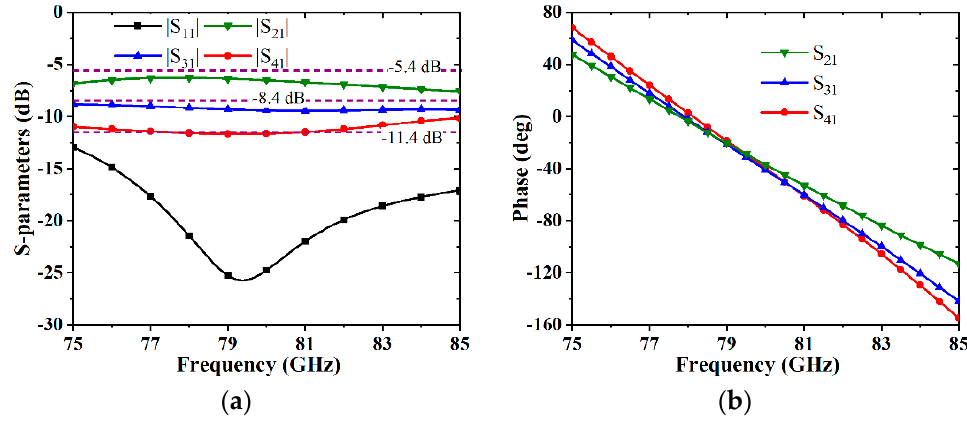
Figure 6. The simulated results of the feeding network. ( a ) S − parameters. ( b ) Output phases.